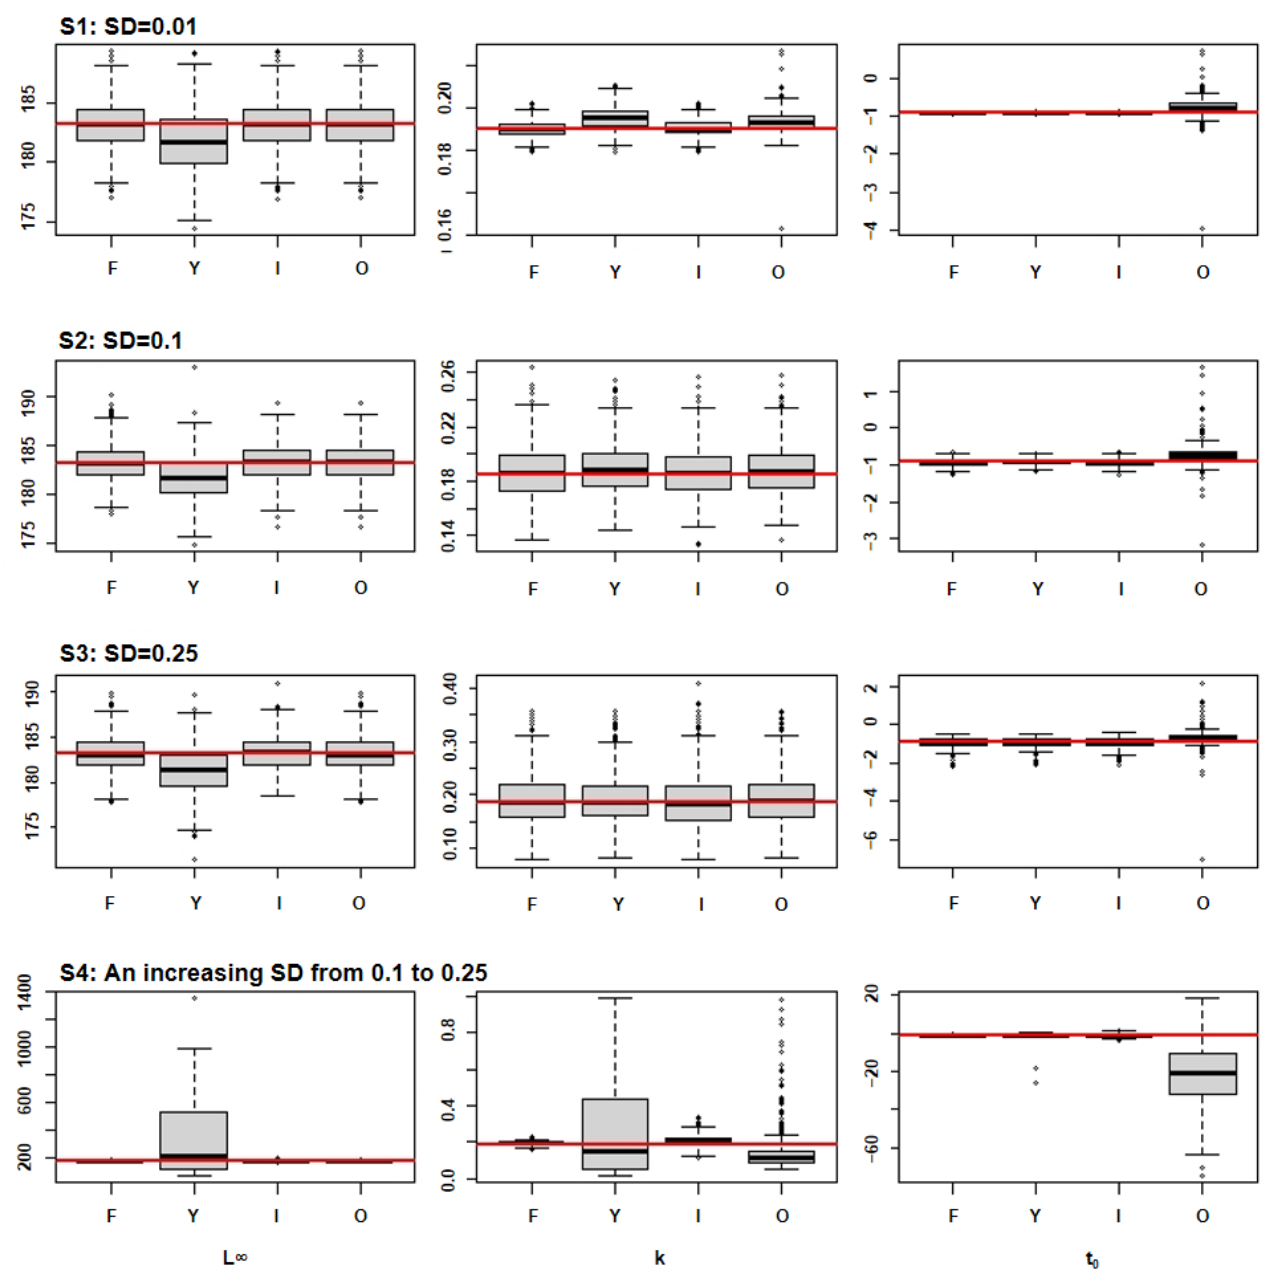
Figure 4. Distributions of estimated growth parameters of simulated southern bluefin tuna (the red line is the initial parameter; L ∞ , k and t 0 are three parameters in the Von Bertalanffy growth model).